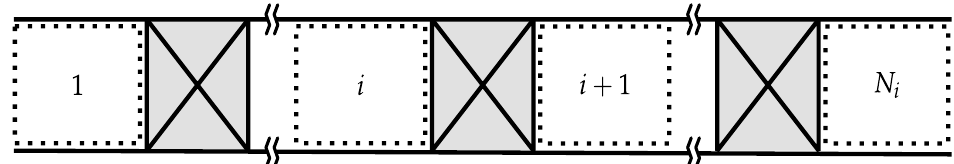
Figure 1. Annulus control volumes i = 1,2, . . . , N i in the semi-actuator disk model. The mean flow is uniform and steady over each of the inlet, outlet, and spaces between blade